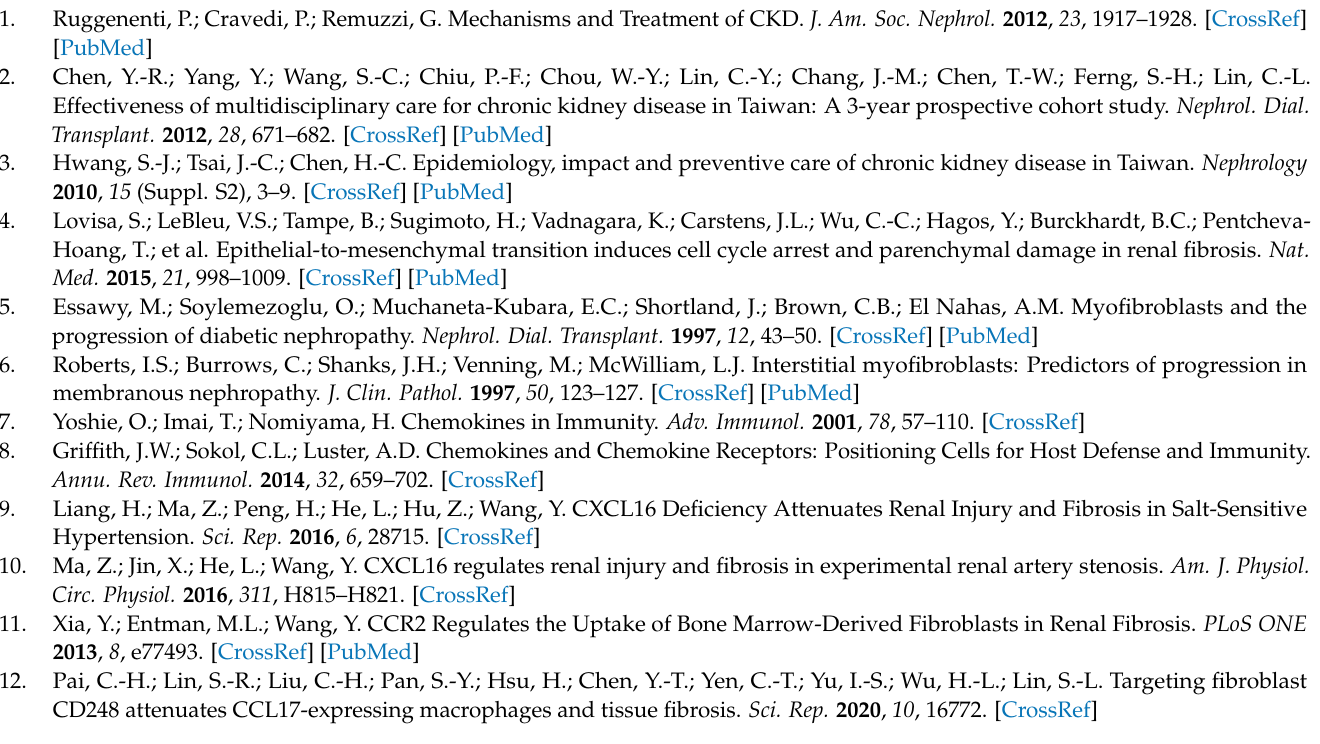
Figure S2: Rh-CCL17 induce the fibrotic- and EMT-related proteins in human HK2 cells; Table S1: Baseline characteristic of eGFR CKD-EPI for normal control, early CKD and advanced CKD